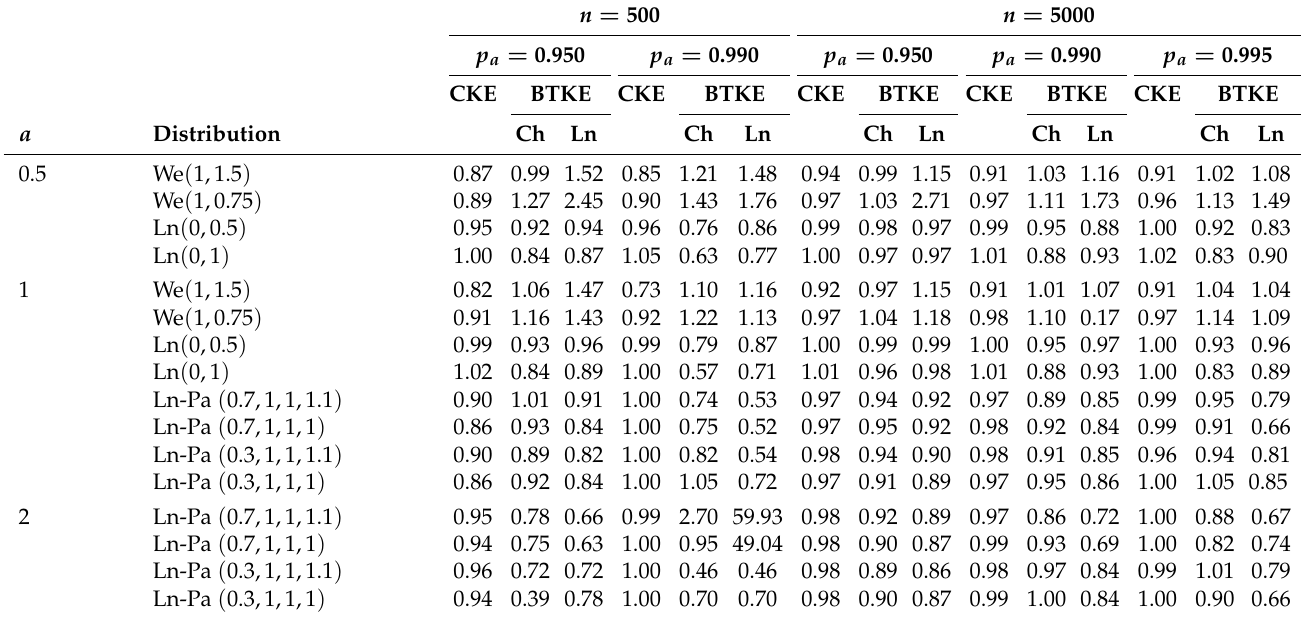
Table A3. Ratios between the MSE (Mean Squared Error) of Beta Transformed Kernel Estimator (BTKE) and Kernel Estimator (KE) of the CQ p and MSE of the estimation based on empirical distribution (Ln-Pa distributions with parameters a ( α , σ , λ , ρ ) , given µ = 0 and c = − 1).